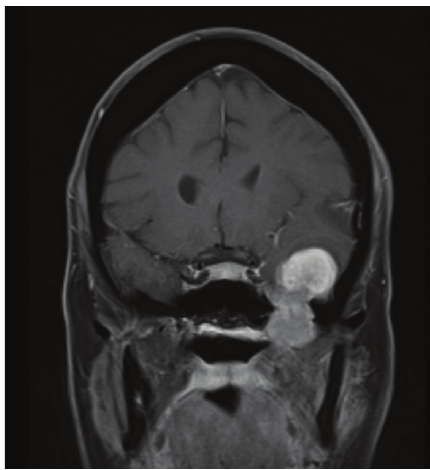
Figure 3: Coronal T1-WI MRI demonstrating middle cranial fossa tumor extending to the infratemporal region.